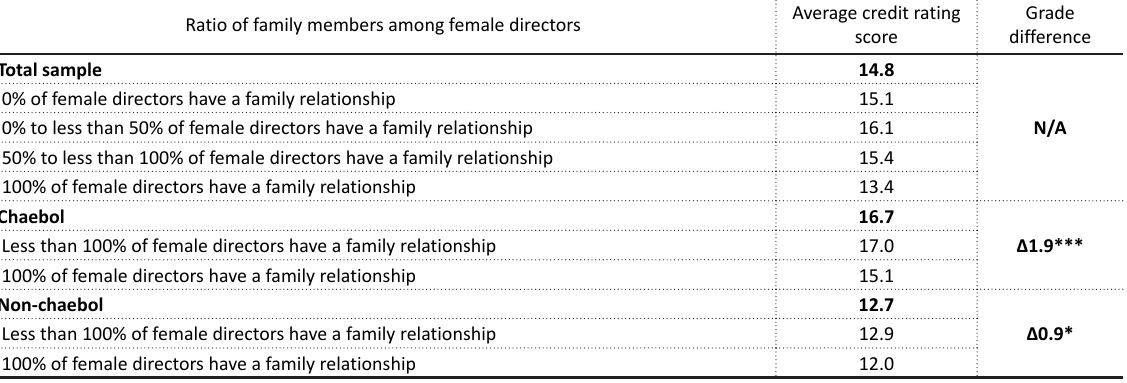
Table 5. Differences in credit ratings based on the ratio of family relationships in firms with female directors